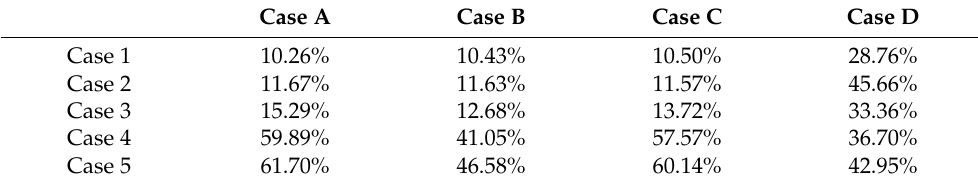
Table 5. Errors of the estimated road roughness using the updated FRF.